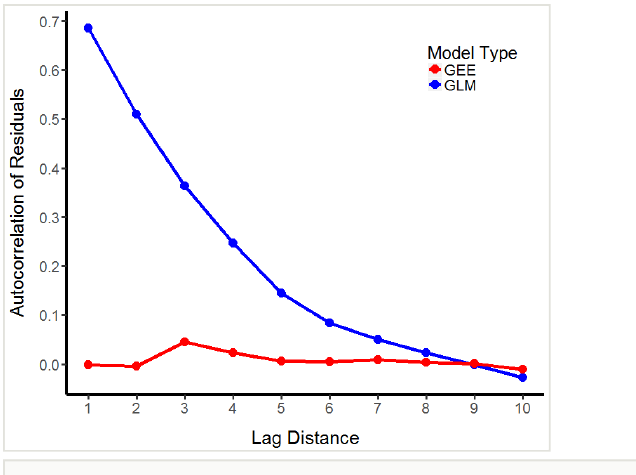
Figure 1. Autocorrelation of residuals from GEE and in comparison to GLM. GEE with correlation structure: fi xed performed best for the musdata data set. Spatial autocorrelation is computed as Moran’s I using the ac ff t function. The fi gure depicts simulated occurrence data of Mus musculus in response to the degree of pollution and the degree of exposure (for instance, to light, noise or other hypothetical risk factors).